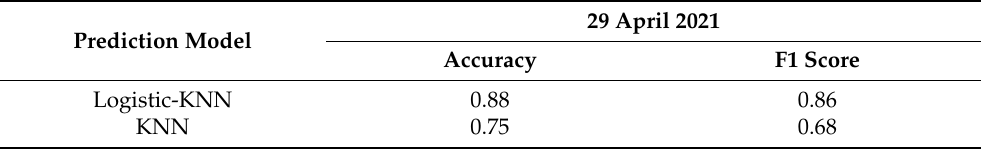
Figure 4. Predictions of FHB severity ( a , b ). The results of the logistic-KNN model are shown on the left, and those of the KNN model are shown on the right. Table 4. Overall accuracies and F1 scores of the two models for 29 April